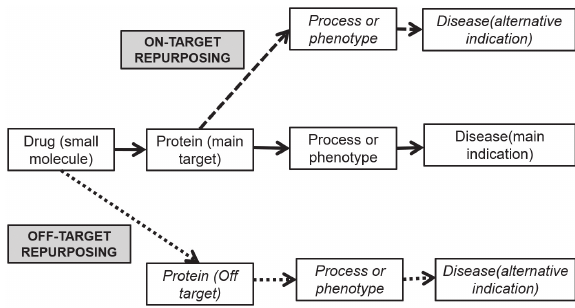
Figure 2. On-target and Off-target drug